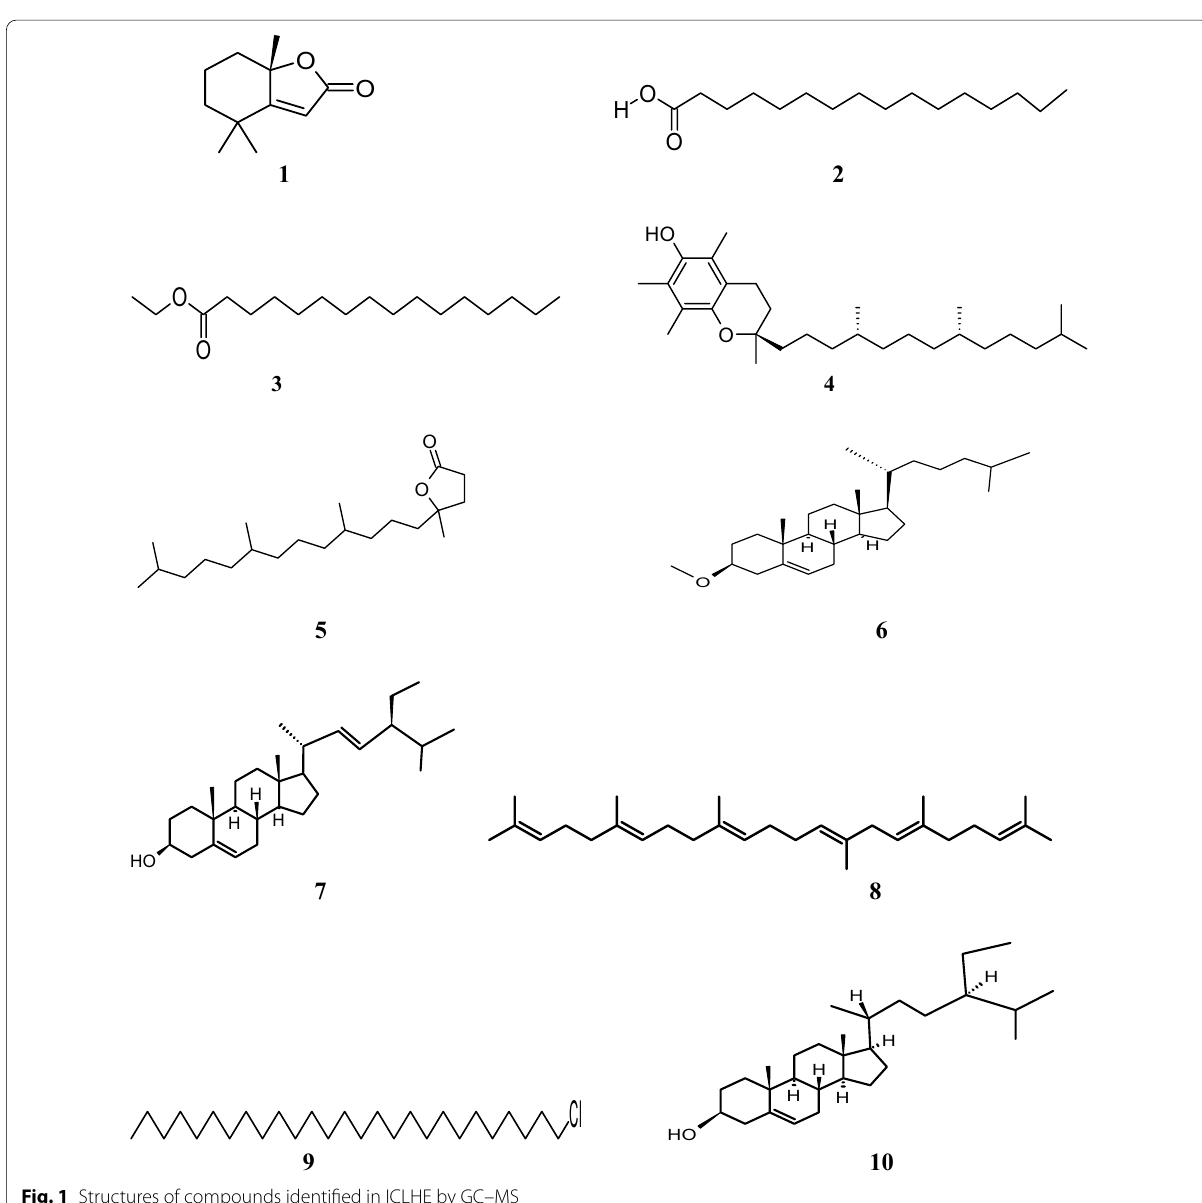
Fig. 1 Structures of compounds identified in ICLHE by